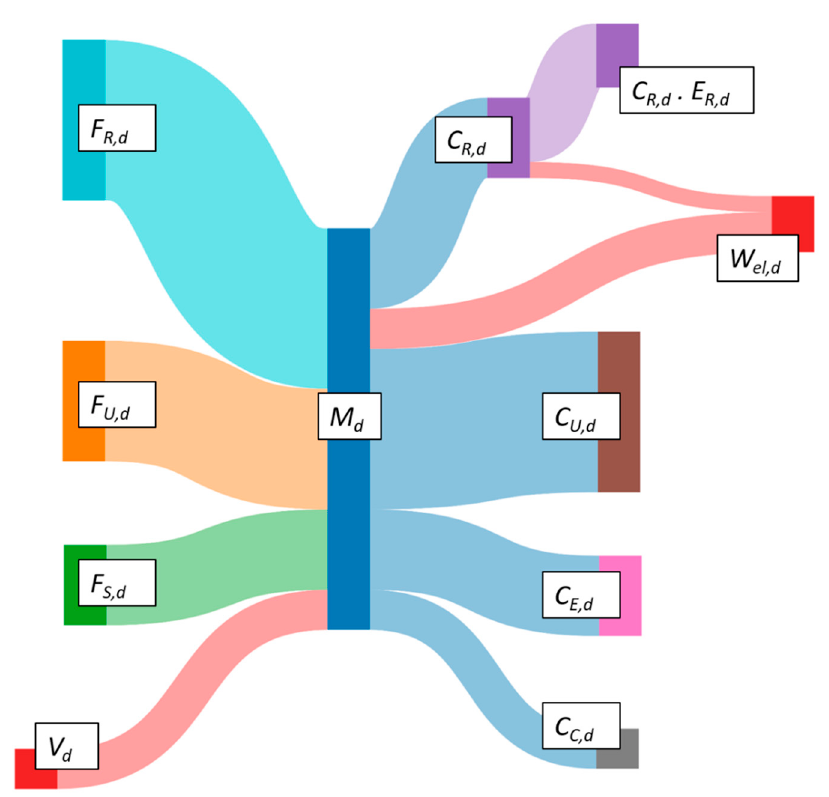
Figure 2. The flow of the different material fractions to be measured on the element level in the design phase.